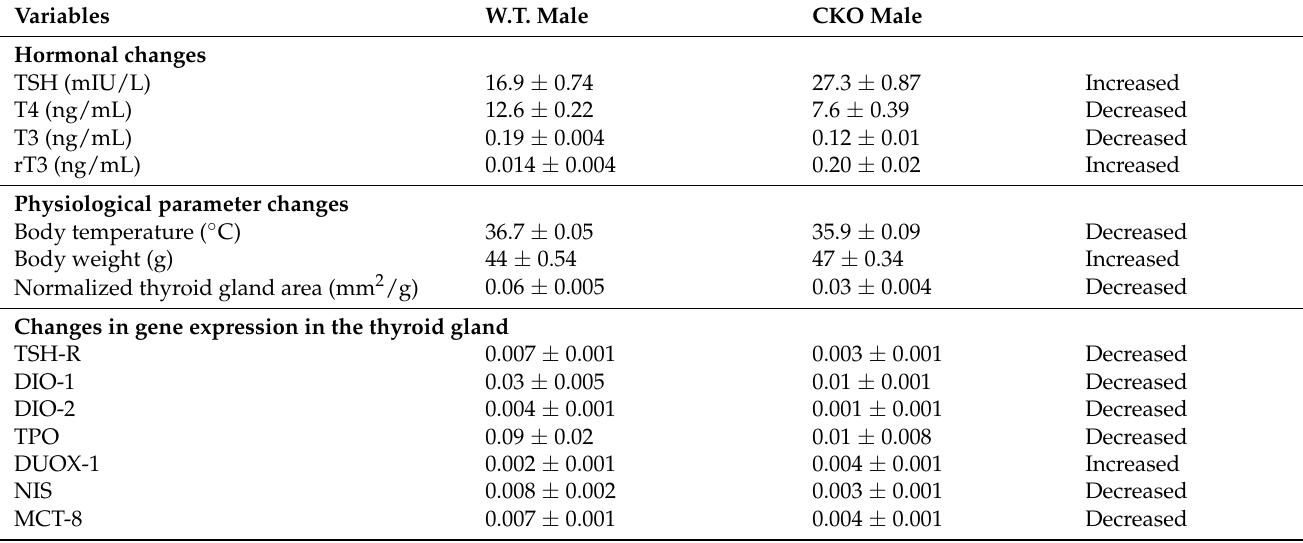
Table 2. Summary of changes in hormonal and physiological parameters and gene expression, comparing CKO and W.T. mice aged 8–9 months